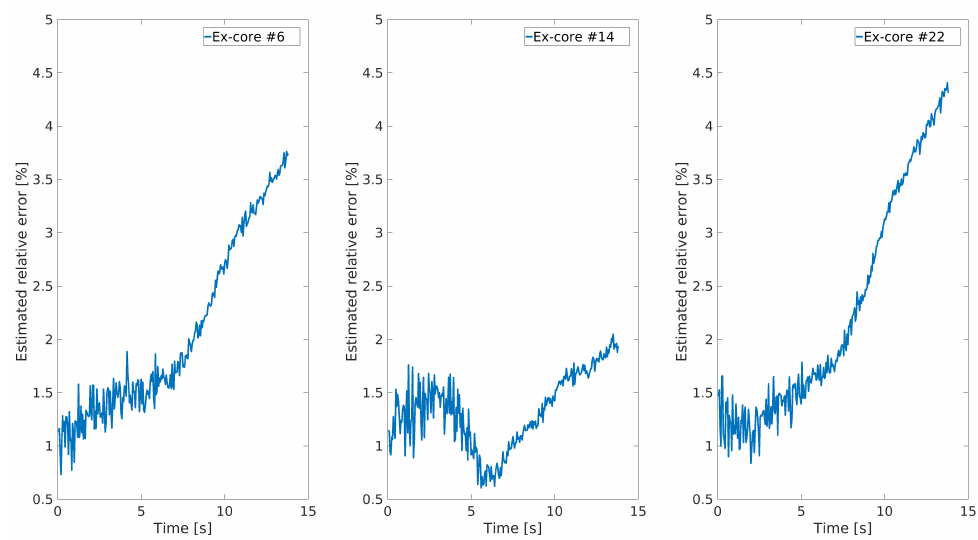
Figure 12. Time evolution of the relative error of ex-ore detector